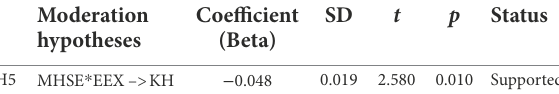
TABLE 9 Hypotheses testing